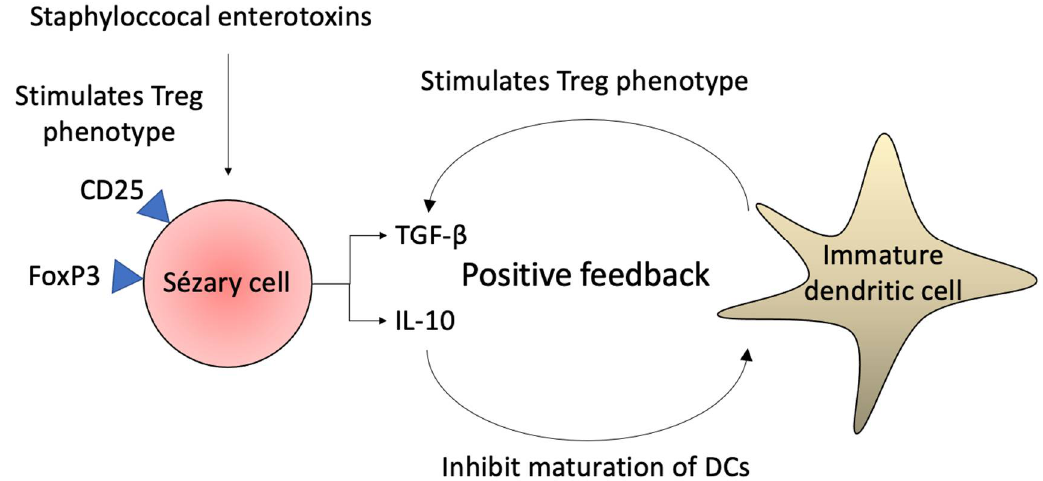
Figure 4. Sézary cell and dendritic cell interaction. The Sézary cells express a Treg phenotype upon Staphylococcal enterotoxins stimulation. The cytokines produced by malignant cells, especially IL-10, prevent DCs from maturating; and the immature DCs promote immune tolerance and persistence of Treg phenotype in Sézary cells in positive feedback.